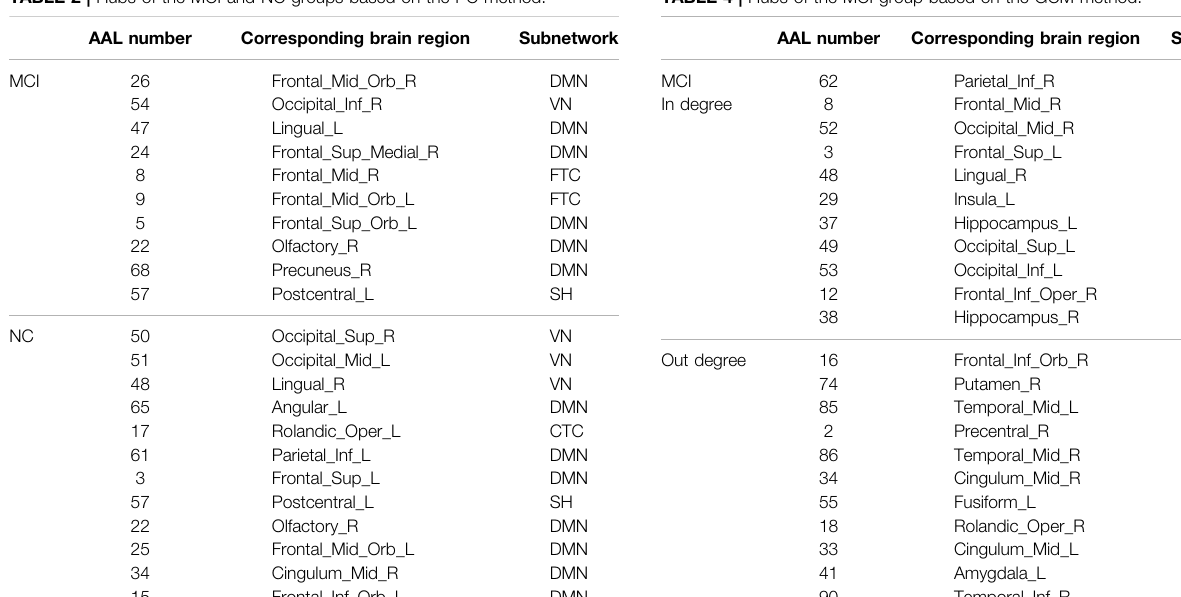
TABLE 2 | Hubs of the MCI and NC groups based on the PC method.